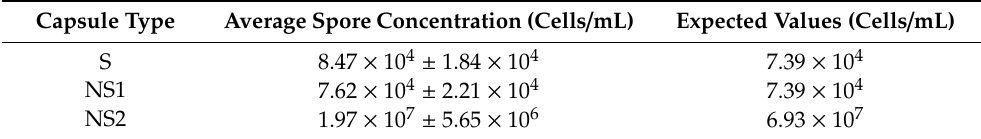
Table 3. The average survival of encapsulated spores from de-cross-linked S, NS1, and NS2 capsules. Capsule